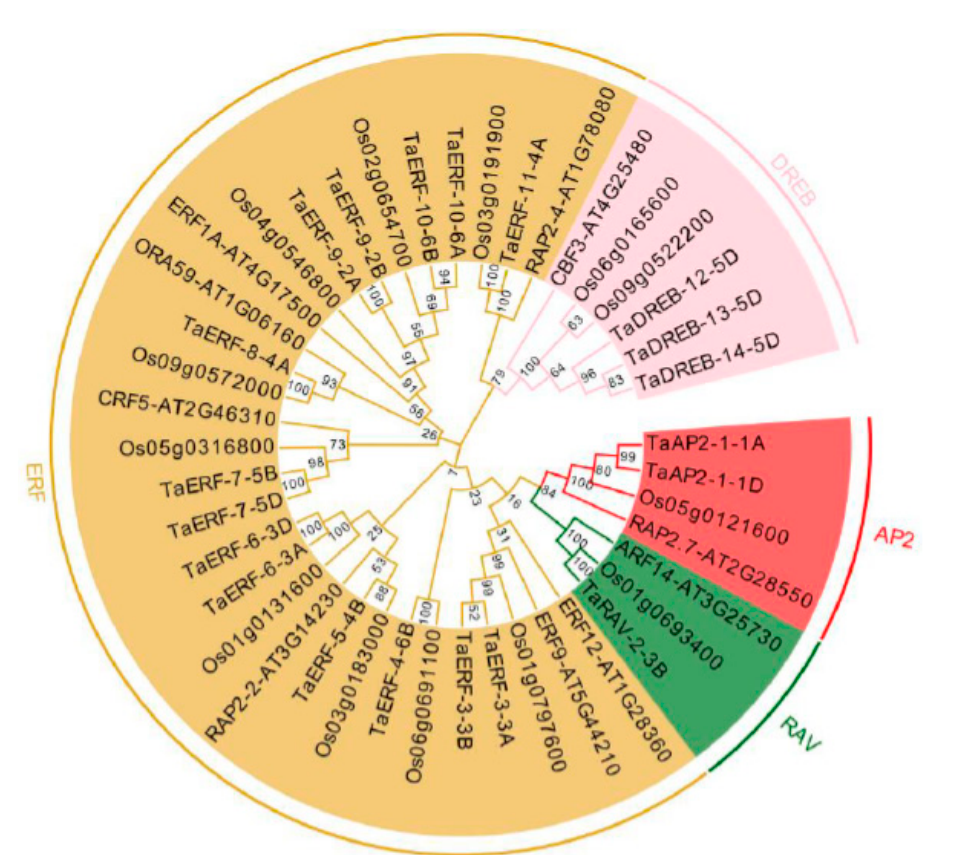
Figure 2. Phylogenetic relationships of wheat, rice, and Arabidopsis AP2/ERF proteins. The neighbor- joining tree was divided into four groups (AP2, RAV, ERF, and DREB).